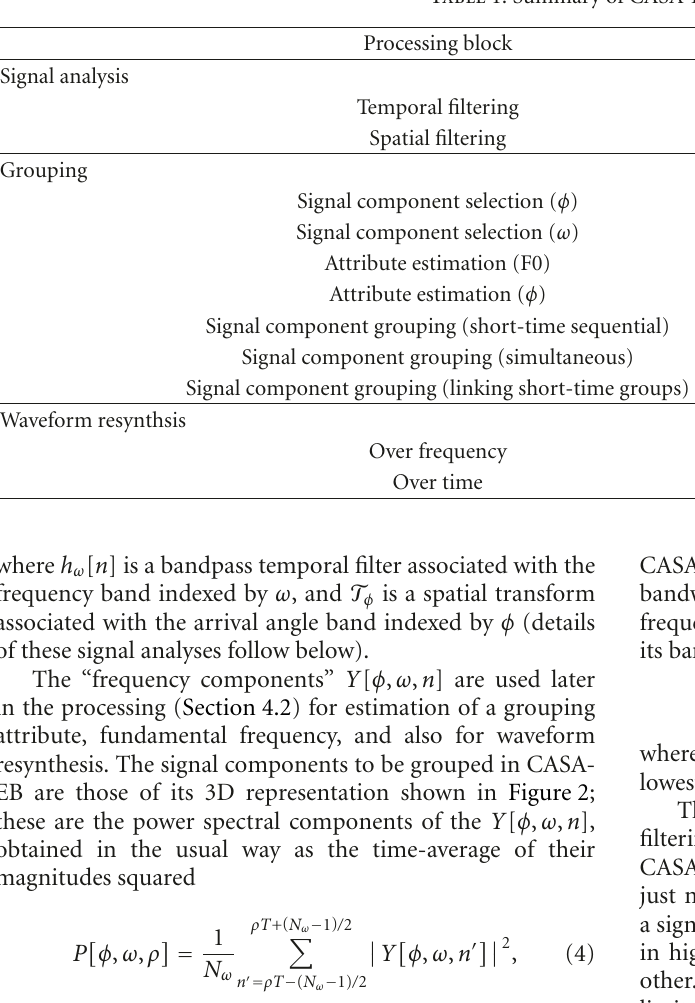
Table 1: Summary of CASA-EB